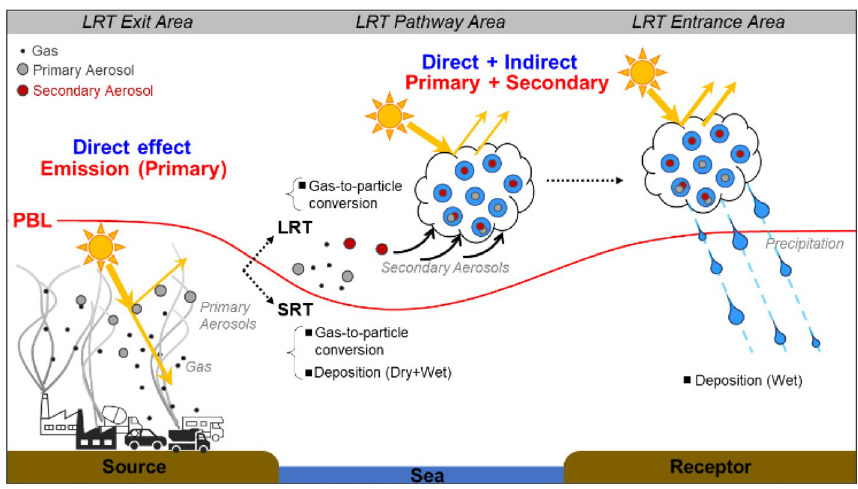
Figure 1. Schematic illustration of aerosol-cloud-precipitation interactions during the long-range transport